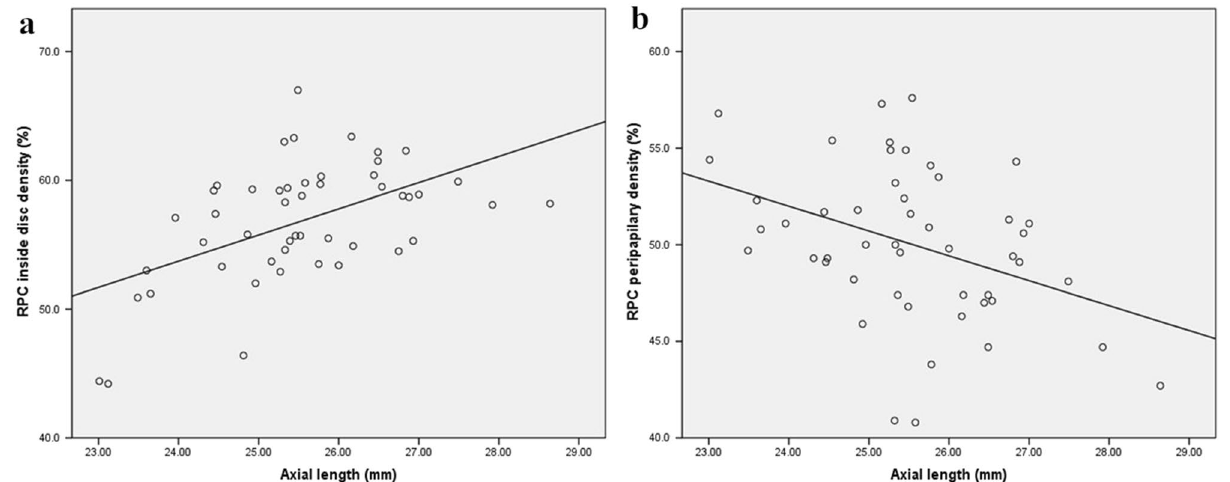
Figure 2. The association between axial length with vessel density inside the disc and in the papillary area ( a ) inside the disc, ( b ) the peripapillary area. RPC: radial peripapillary capillary.